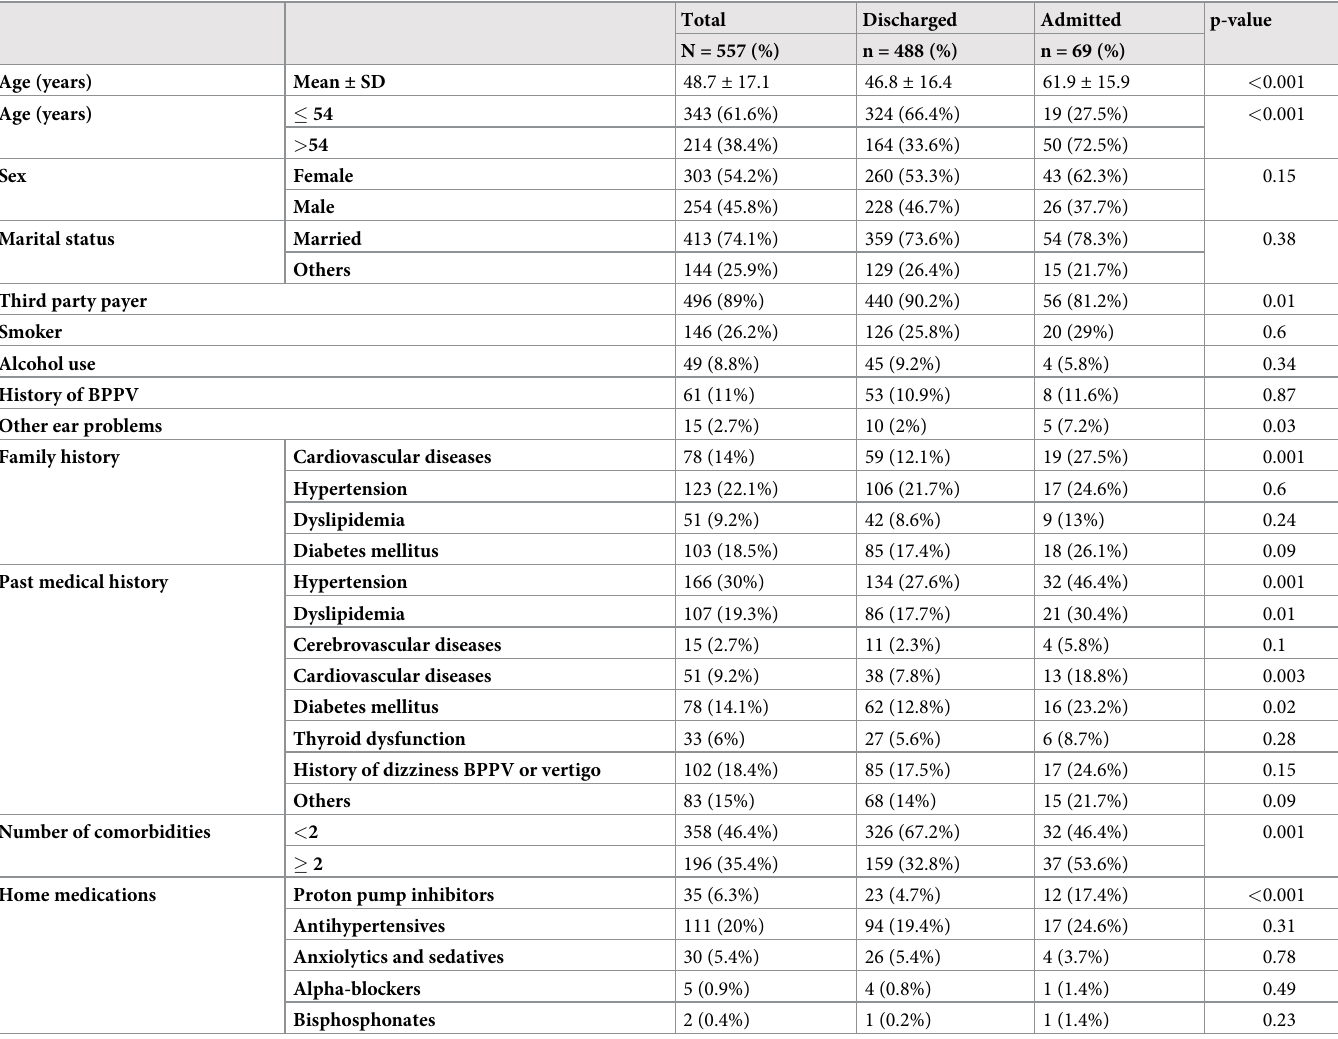
Table 1. Baseline characteristics of BPPV